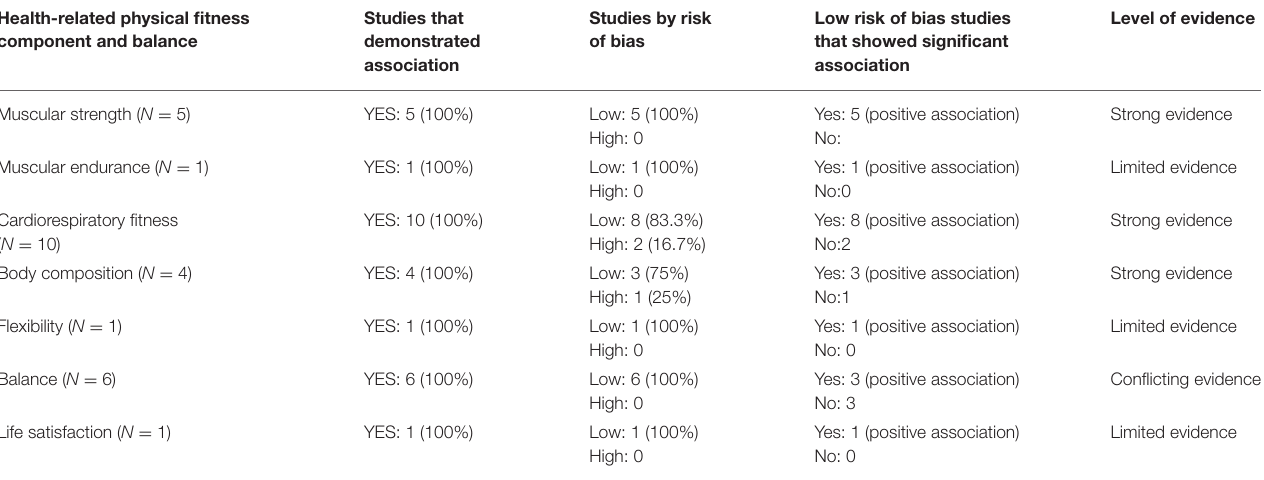
TABLE 4 | The study of brisk walking and health-related physical fitness components was classified according to the risk of bias within the studies and the strength of the scientific evidence. Health-related physical fitness component and balance